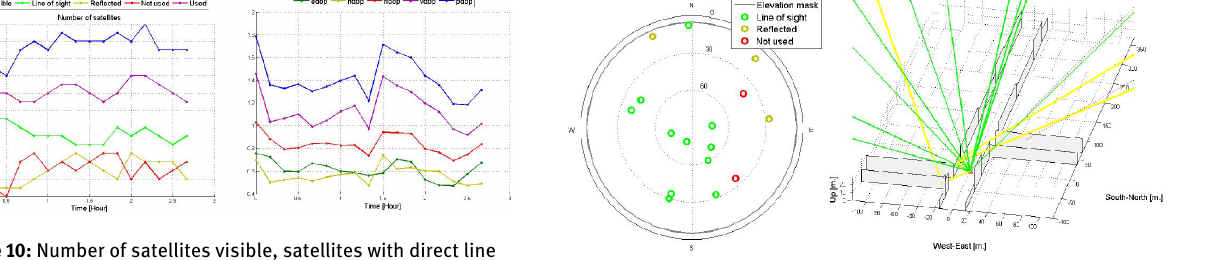
Figure 12: Satellite geometry and illustration of signals with direct line of sight as well as reflected signals and signals blocked.